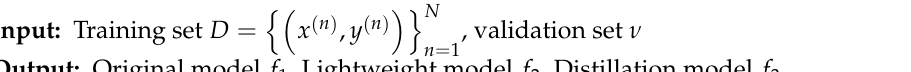
Algorithm 1 The overall algorithm